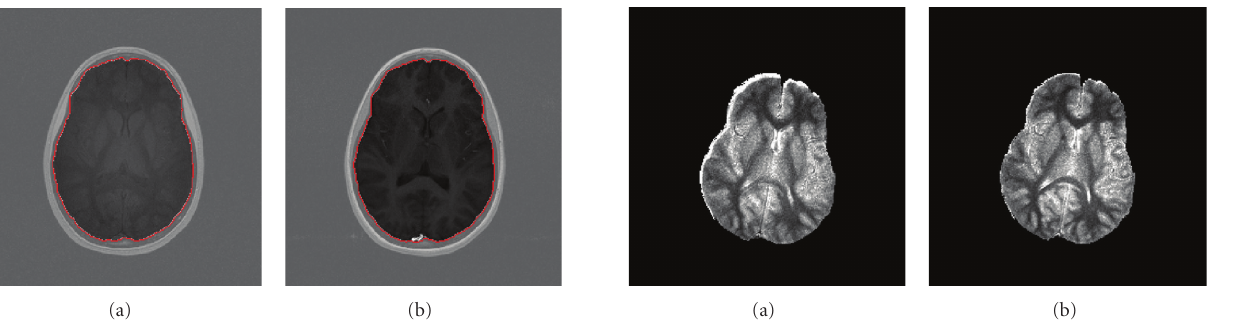
Figure 5: The T 1 -Map generated by (a) unregistered and (b) registered flip angle images. It can be seen that the anatomical structure of the registered one is clearer than the other.